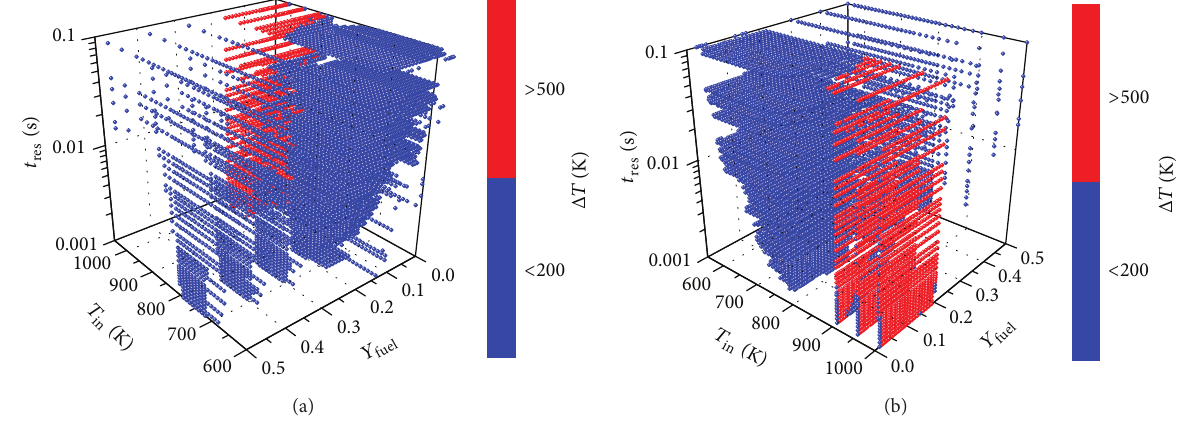
Figure 12: Predictions of PSR temperature increase as a function of inlet temperature, fuel concentration, and residence time.